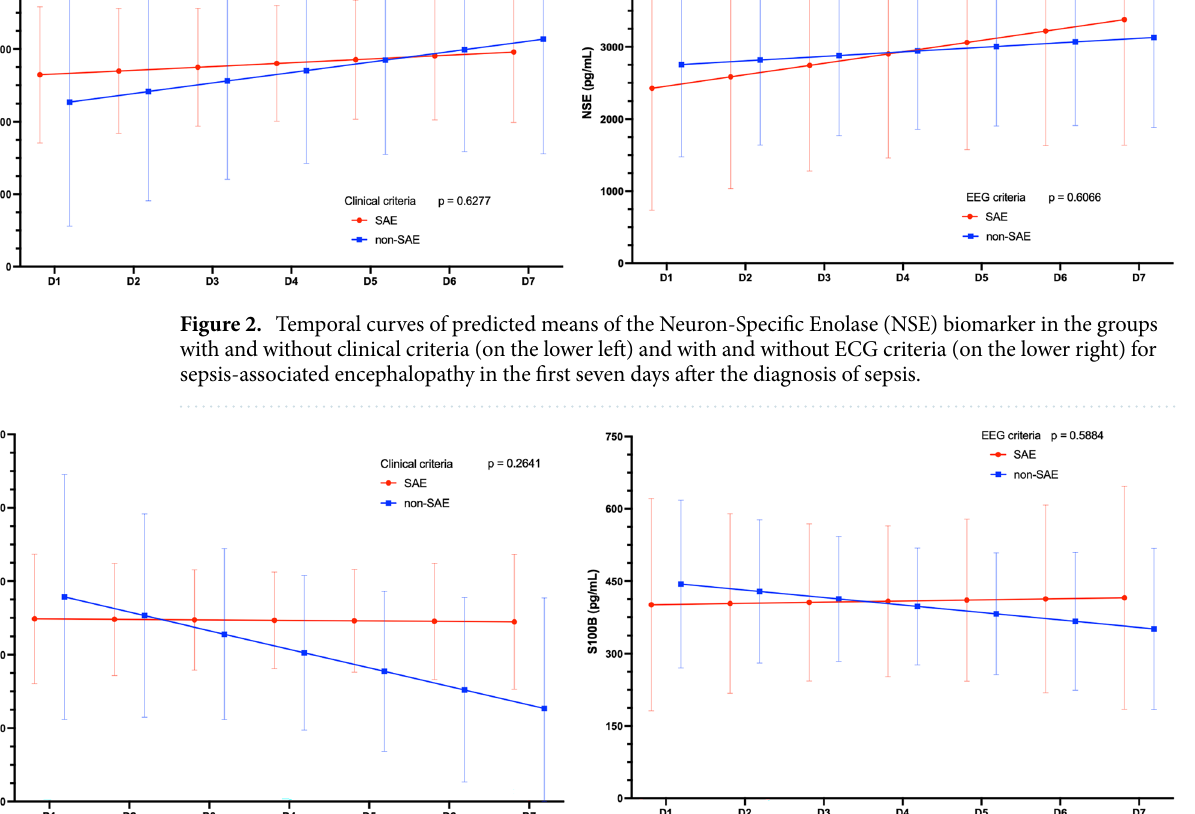
Figure 3. Temporal curves of predicted means of the S100 calcium-binding protein B (S100B) biomarker in the groups with and without clinical criteria (on the lower left) and with and without ECG criteria (on the lower right) for sepsis-associated encephalopathy in the first seven days after the diagnosis of